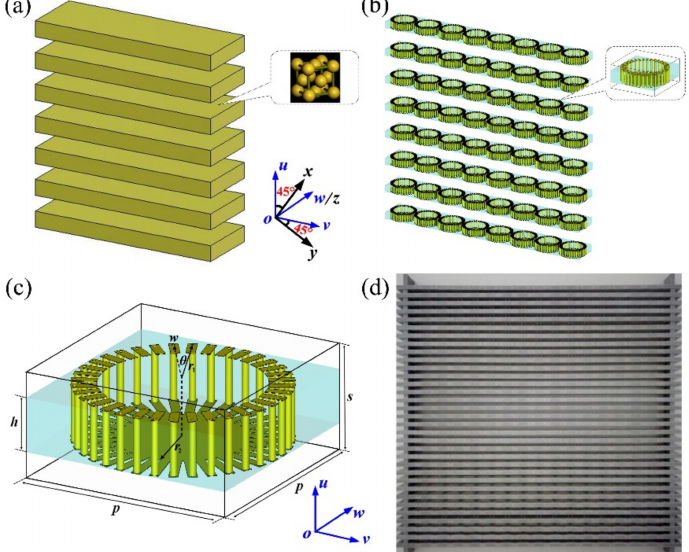
Figure 1. Schematic diagram of ( a ) the metallic subwavelength grating, ( b ) the proposed metagrating, and ( c ) the unit cell of metagrating. The u - and v -axis are the two principal axes of the metagrating, respectively. The direction of the x ( y )-axis is rotated by 45 ◦ with respect to the u ( v )-axis. ( d ) Photograph of the experimental